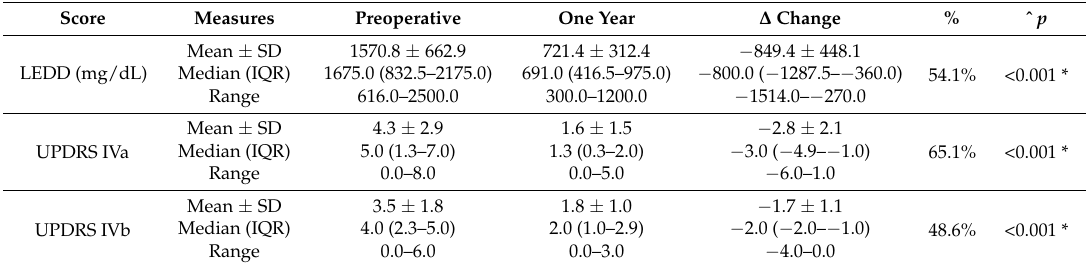
Table 5. Changes in the LEDD and UPDRS IV score.